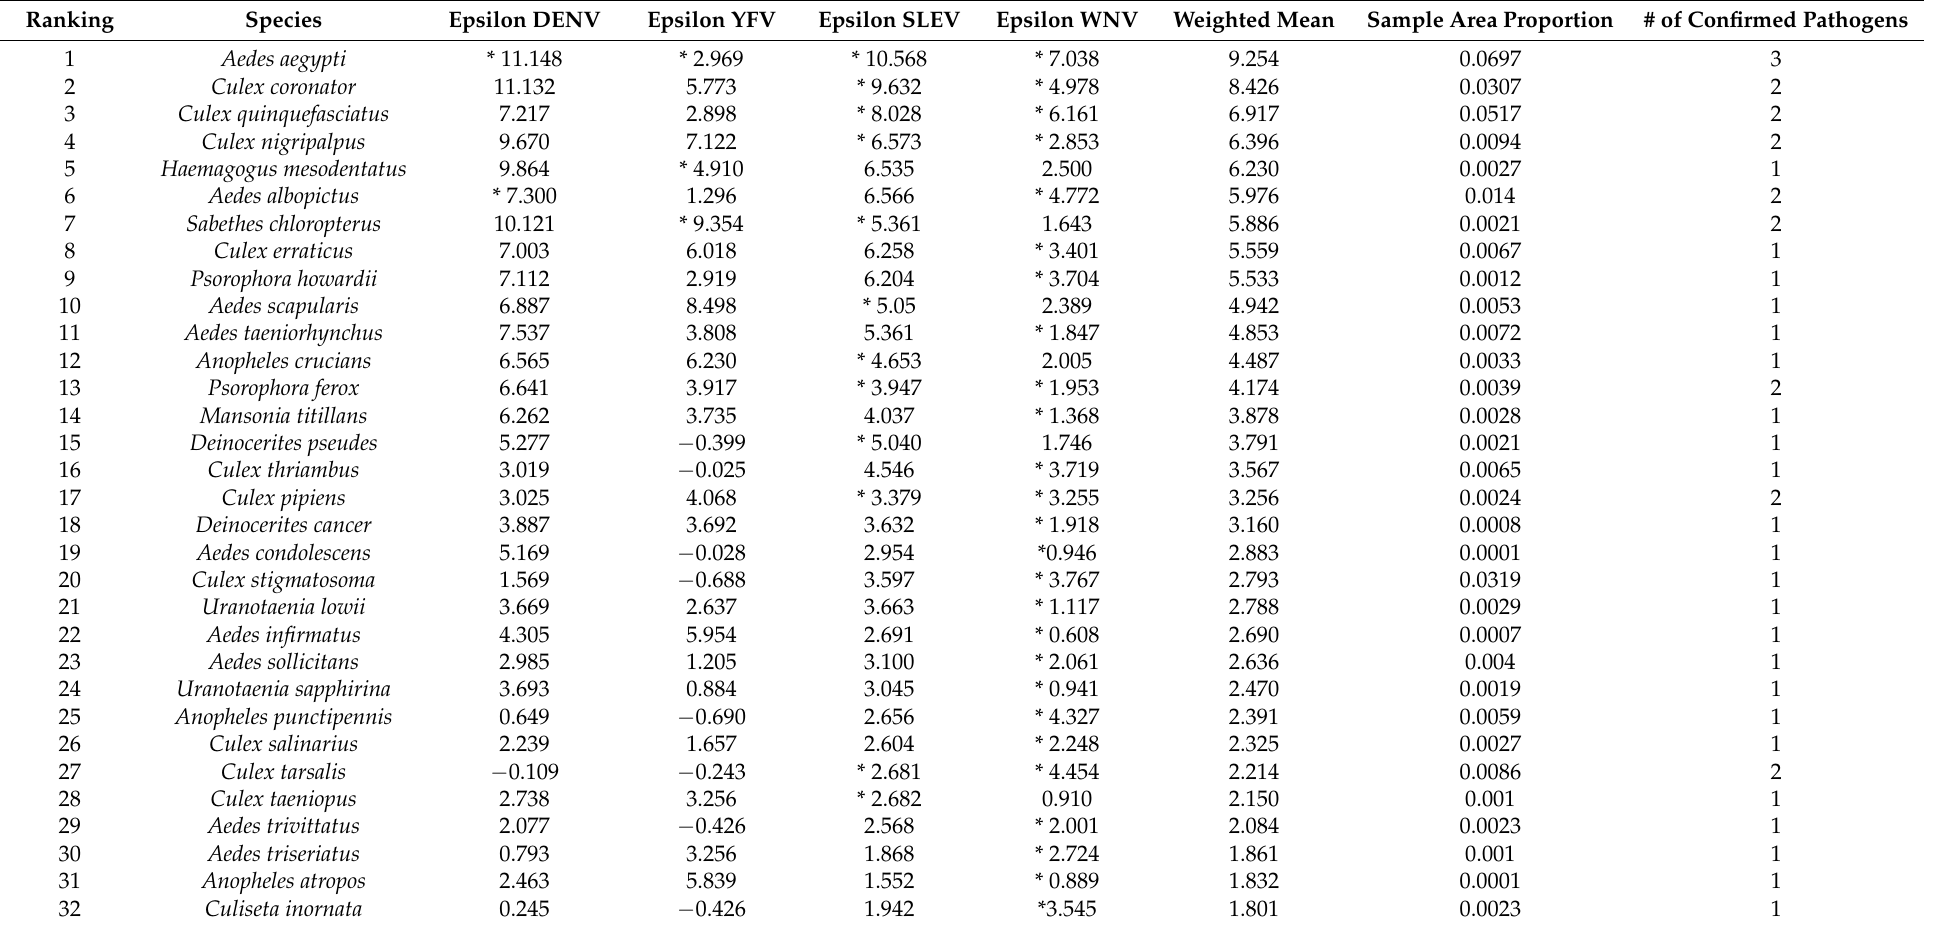
Table 1. List of known vectors for the four mosquito-borne flaviviruses (MBFVs) considered and their weighted ε values calculated from the co-occurring positive mammal species for each MBFV and for all